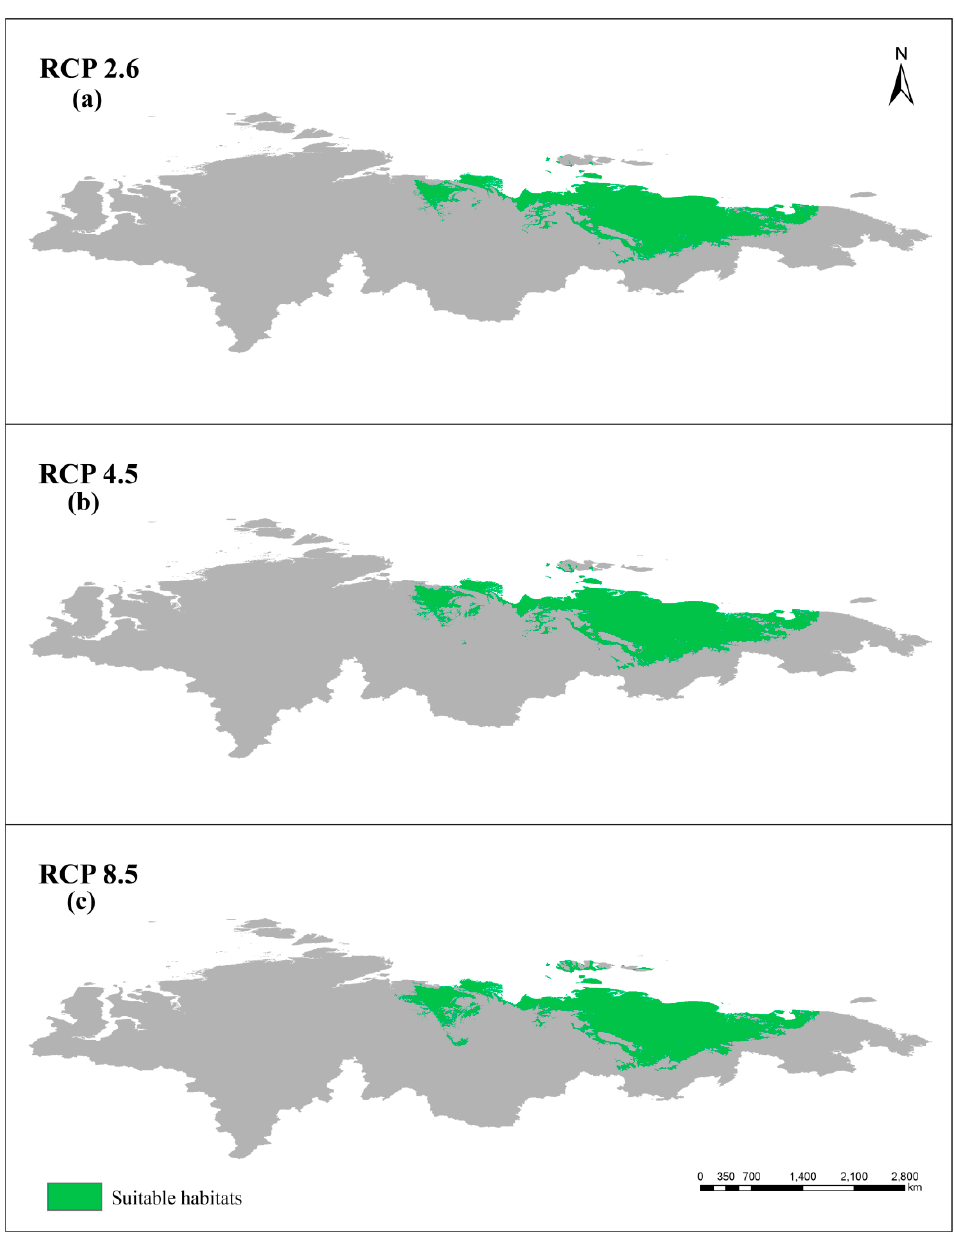
Figure 4. Distribution of appropriate habitat and breeding sites for lesser white-fronted goose in 2070 under ( a ) current conditions, ( b ) RCP2.6, ( c ) RCP4.5, and ( d ) RCP8.5.